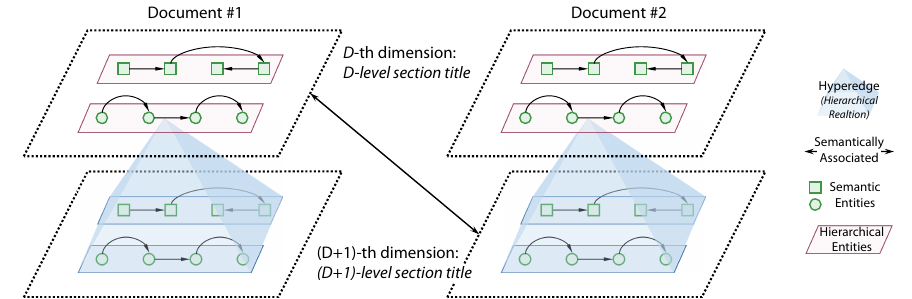
Figure 6. Metaknowledge that modeled by multi-dimensional hyper-graph with hierarchical